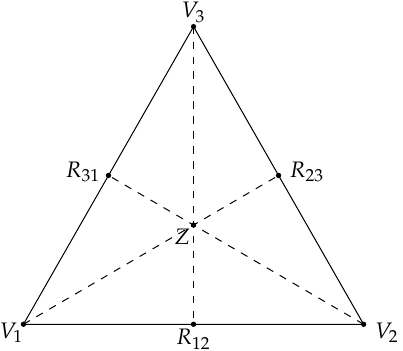
Figure 4. A Powell–Sabin split of the triangle T = (cid:104) V 1 , V 2 , V 3 (cid:105)